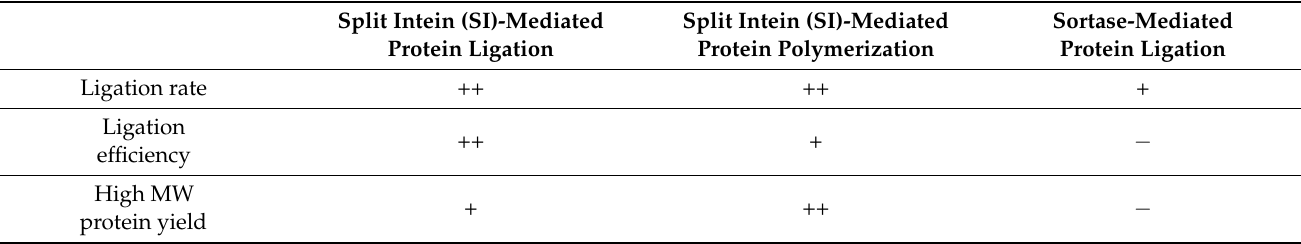
Table 2. Comparison between different methods for ligation of the protein backbones via peptide bonds. “ − “, “+” and “++” symbols indicate the respective levels of each criterion. Split Intein (SI)-Mediated Split Intein (SI)-Mediated Sortase-Mediated Protein Ligation Protein Polymerization Protein